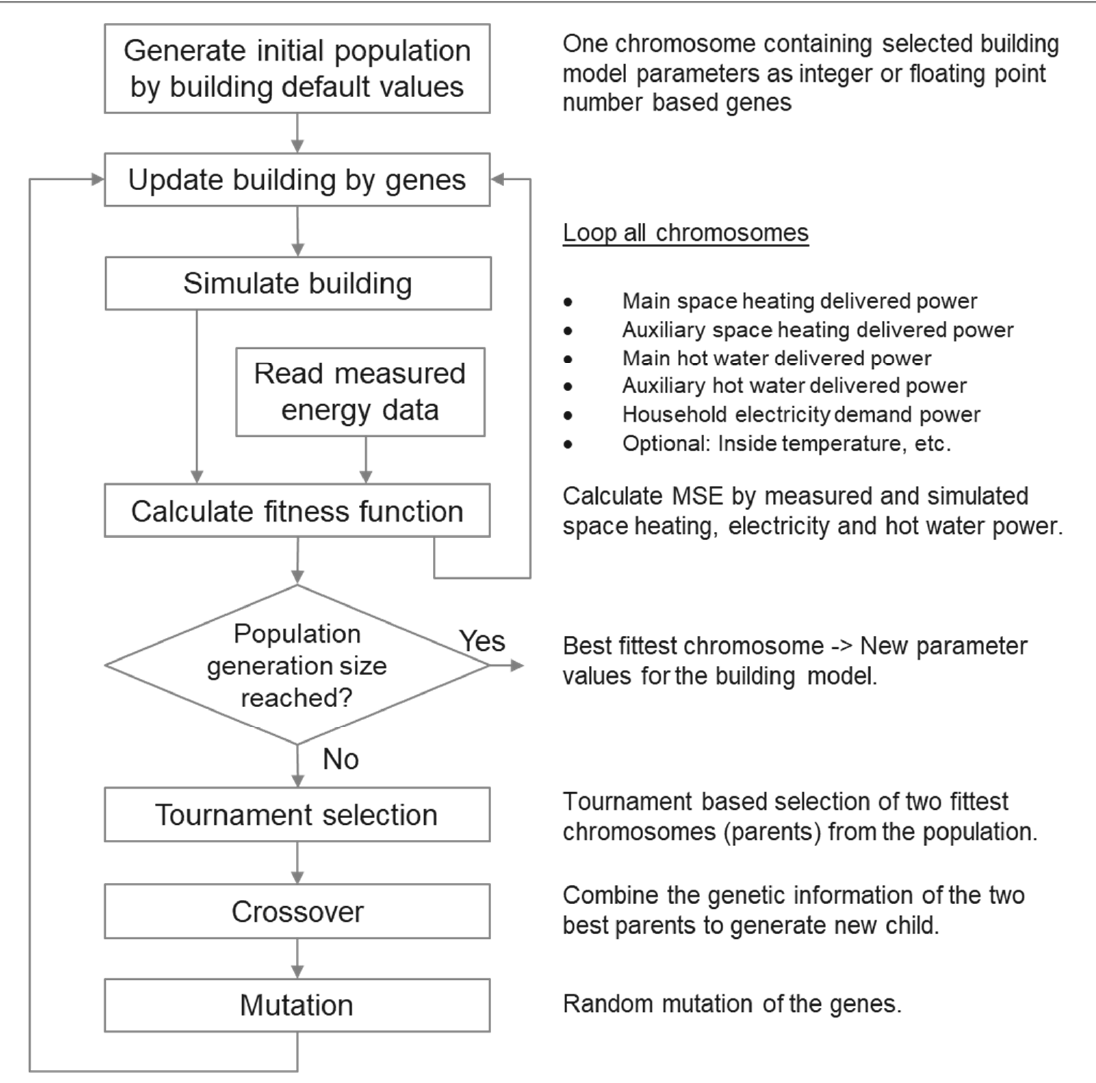
Figure 2. GA-based learning of building model parameters.